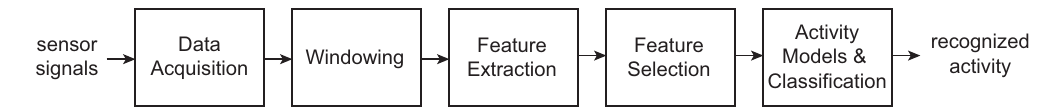
Figure 7. Activity recognition chain methodology adopted in the fall detection